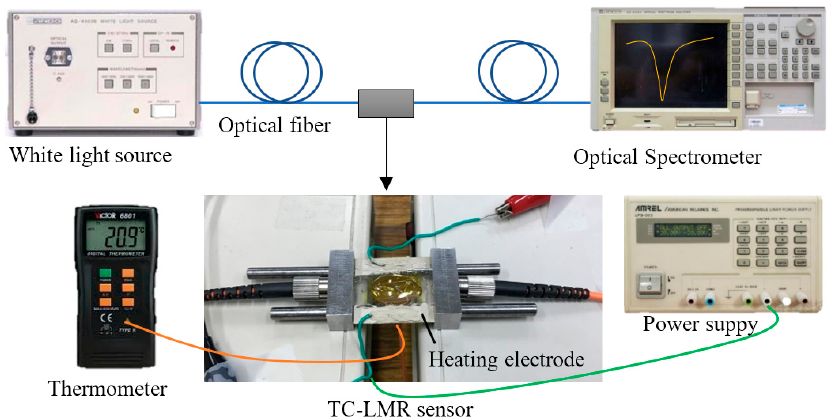
Figure 1. A schematic diagram of the experimental setup and a photograph of the TC-LMR sensor on the optical alignment platform.